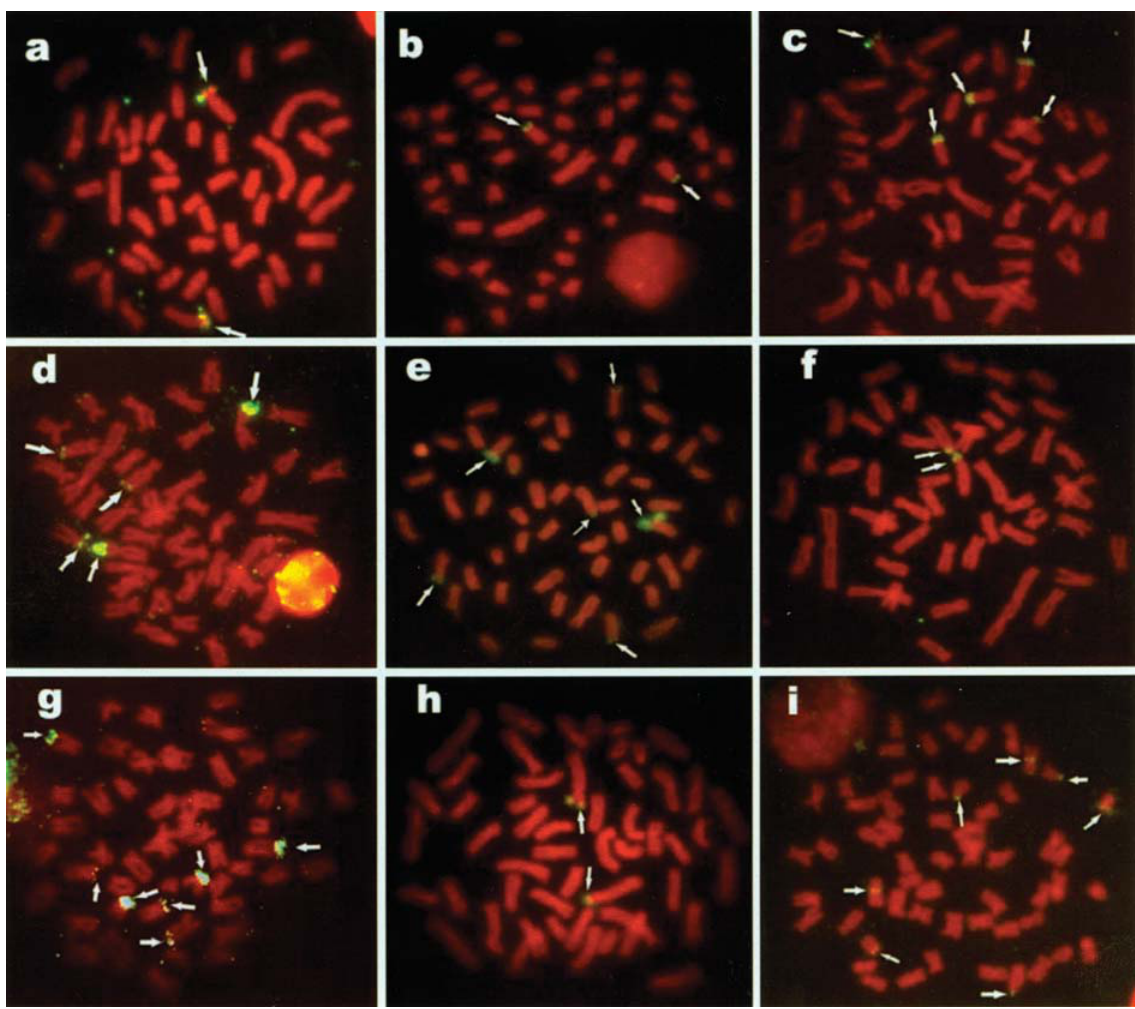
Figure 1 - Localization of 18S rDNA sites (arrows in (a) Astyanax altiparanae; (b) A. lacustris; (c) A. scabripinnis ; (d) Hasemania nana ; (e) Piabina argentea ; (f) Orthospinus. franciscensis ; (g) Serrapinnus. piaba ; (h) S. heterodon ; (i) Myleus